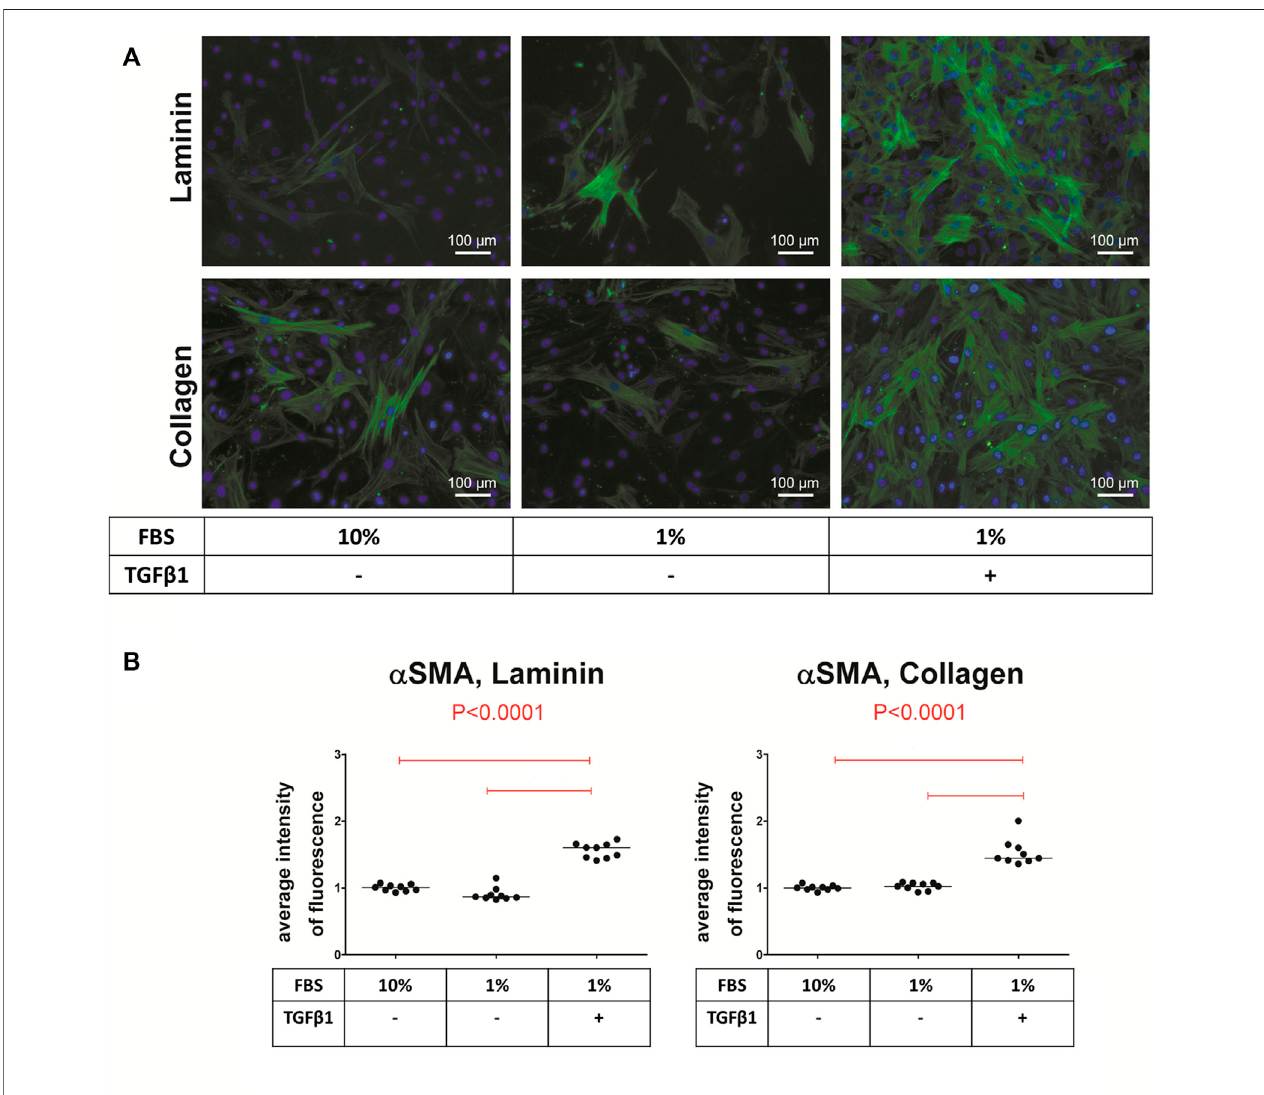
FIGURE 5 | Immuno fl uorescence staining of valve interstitial cells (VIC) for alpha-smooth muscle actin ( α SMA). (A) VIC were isolated from aortic valves with calci fi cation(n=9)andculturedfor14daysoneitherlamininorcollagen,with10%FBSwithoutTGF β -1,with1%FBSwithoutTGF β -1orwithTGF β -1. α SMA(green),cell nuclei (Hoechst 3342/blue). (B) Quanti fi cation of α SMA fl uorescence, shown as scatter plot with median. Statistical differences were tested using ANOVA followed by Tukey test. Overall p -values from ANOVA analysis are shown in red.